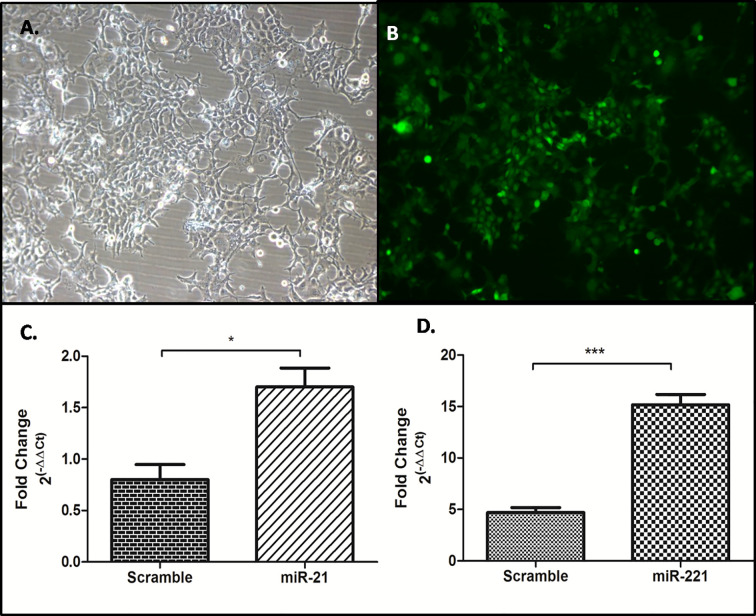
Generation of stable cell line overexpressing miR-21, -221, and miR-Scr. Stable selection of Huh7 cell lines were carried out by zeocin selection (A) and confirmed by reporter GFP expression (B), Overexpression of miR-21 (C), and miR- 221 (D) compared to miR-Scr was checked by miR specific SYBR green based real time PCR after normalization with U6 snRNA. (*P ≤ 0.05), (***P ≤ 0.0001).